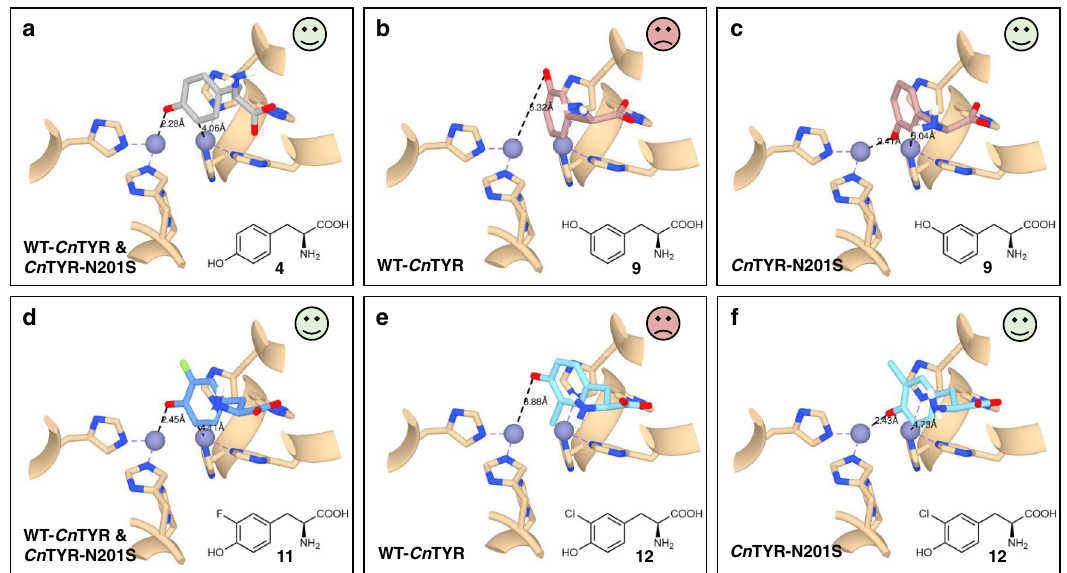
Fig. 4 | Molecular docking studies with WT- Cn TYR and the variant N201S. WT- Cn TYR and the variant N201S (homology modelled) with L-tyrosine 4 , meta -L-tyr- osine 9 and halogenated tyrosines 11 and 12 using AutoDock Vina 35 . a Docking of L-tyrosine 4 withthewild-type (WT) Cn TYRand Cn TYR-N201S:L-tyrosine 1 fi tswell into the active sites of WT- Cn TYR and Cn TYR-N201S. b Docking of meta -L-tyrosine 9 with the WT- Cn TYR: 9 can fi t into the active site of WT- Cn TYR but not in a productiveorientation. c Dockingof 9 with Cn TYR-N201S: 9 fi tswellintotheactive site of Cn TYR-N201S. d Docking of 3-F-L-tyrosine 11 with WT- Cn TYR and Cn TYR- N201S: 11 fi ts well into the active site of both. e Docking of 3-Cl-L-tyrosine 12 with